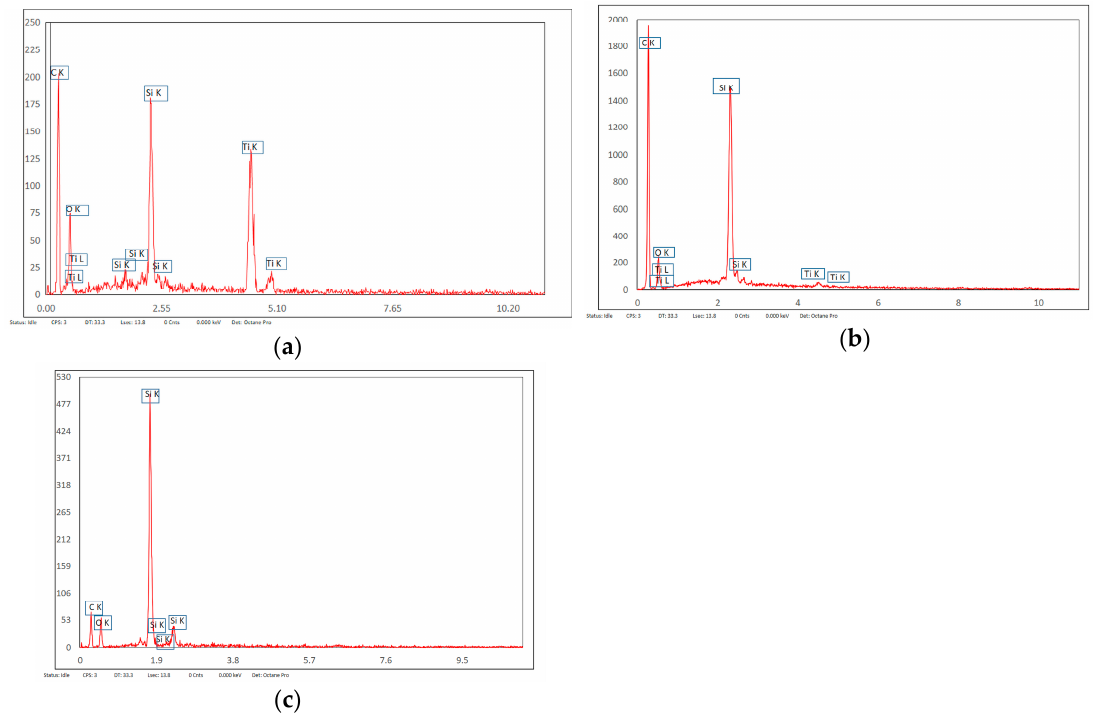
Figure 7. EDX analysis—surface composition of polysulfone—titanium dioxide grafted silica microfiber composite membranes: ( a ) Surface of titanium dioxide spherical deposition, ( b ) silica microfiber grafted with titania, and ( c ) top surface of the composite membrane.